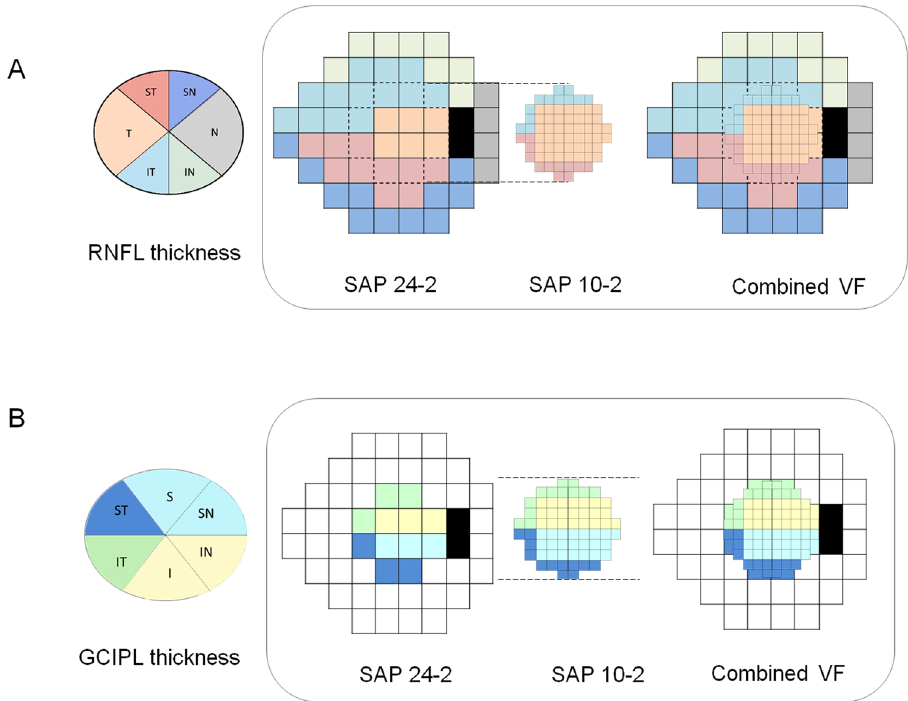
Figure 2. Structure–function correspondence map according to Garway-Heath et al 7 . ( A ) Topographic RNFL thickness and the corresponding VF sectors in 24-2 or 10-2 SAP and the combined VF test ( B ) Topographic GCIPL thickness and the corresponding 24-2 or 10-2 SAP or the combined VF test. The figure was prepared using the Excel and PowerPoint program in Microsoft Office 365 (https ://www.offic e.com/, freely available for teachers at qualified academic institutions). I = inferior; IN = inferonasal; IT = inferotemporal; N = nasal; S = superior; SN = superonasal; ST = superotemporal; T =